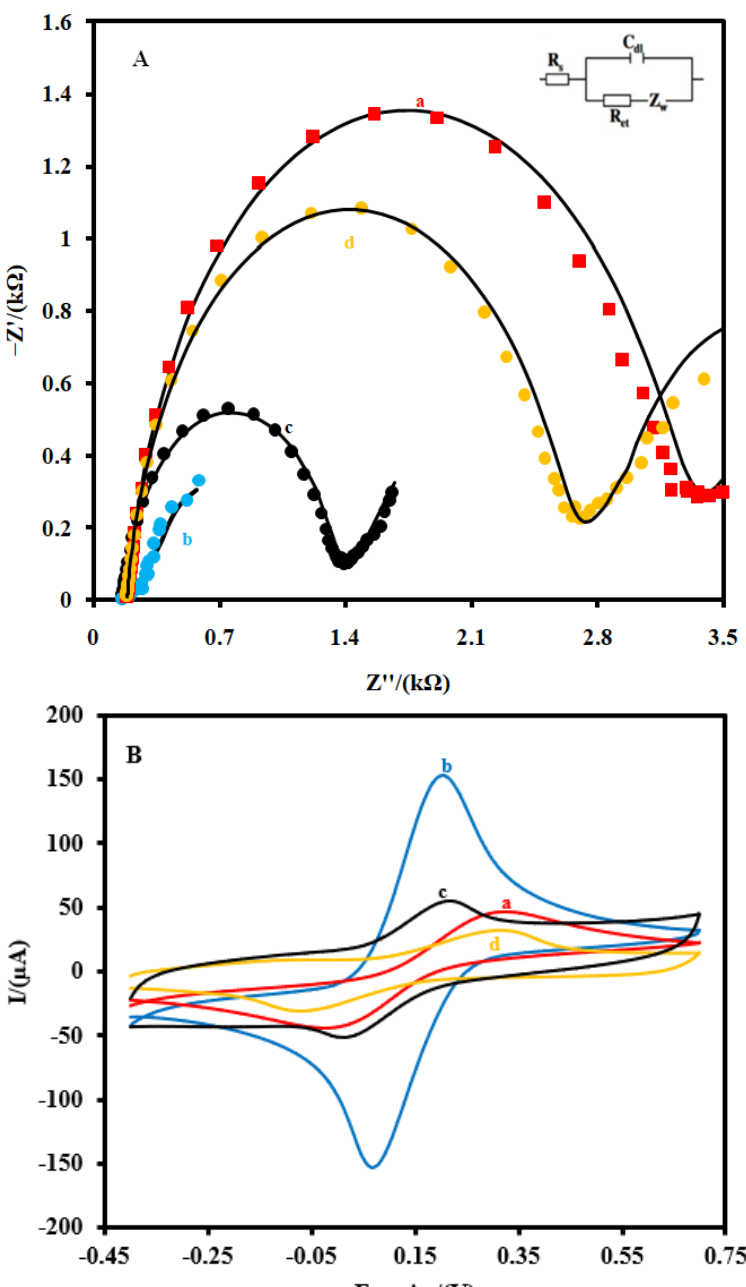
Figure 3. ( A ) EIS and ( B ) CVs and of the CSPE ( a ) the CSPE/CNFs–AuNPs ( b ), the CSPE/CNF–AuNP/Aptamer ( c ), and the CSPE/CNF–AuNP/Aptamer/SARS-CoV-2-RBD ( d ) at 0.1 M 5.0 mM Fe(CN) 63 − /4 − solution (0.1 M PBS, pH 7.4). The equivalent electric circuit is compatible with the Nyquist diagrams. R s : Solution resistance; R ct : charge transfer resistance; C dl : Double